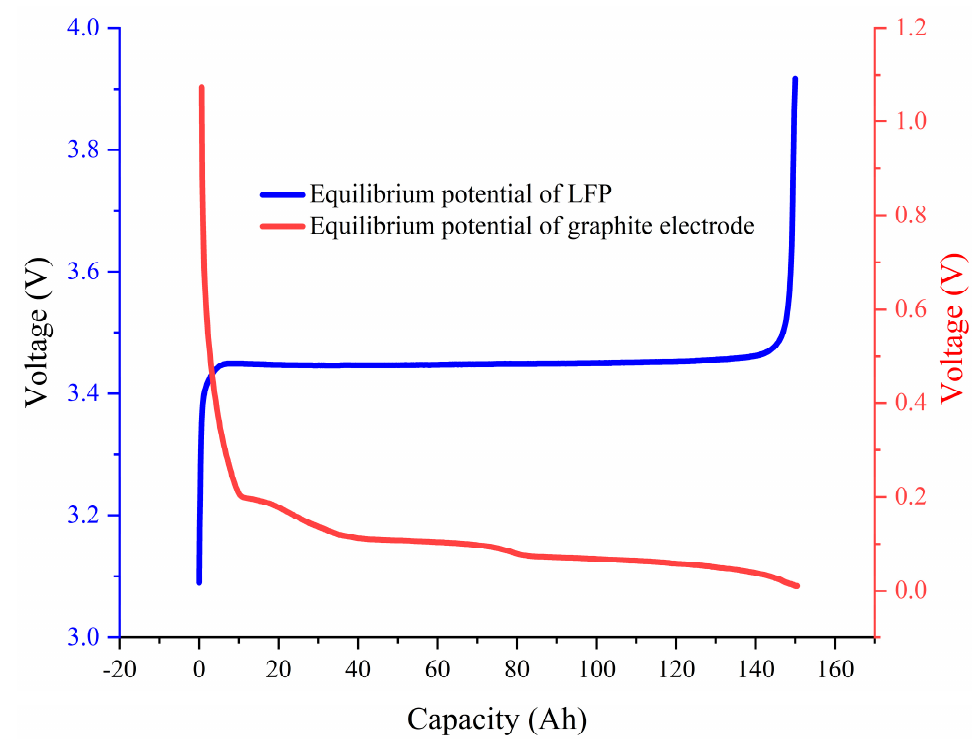
Figure 2. Equilibrium potential curve of large-size cell.